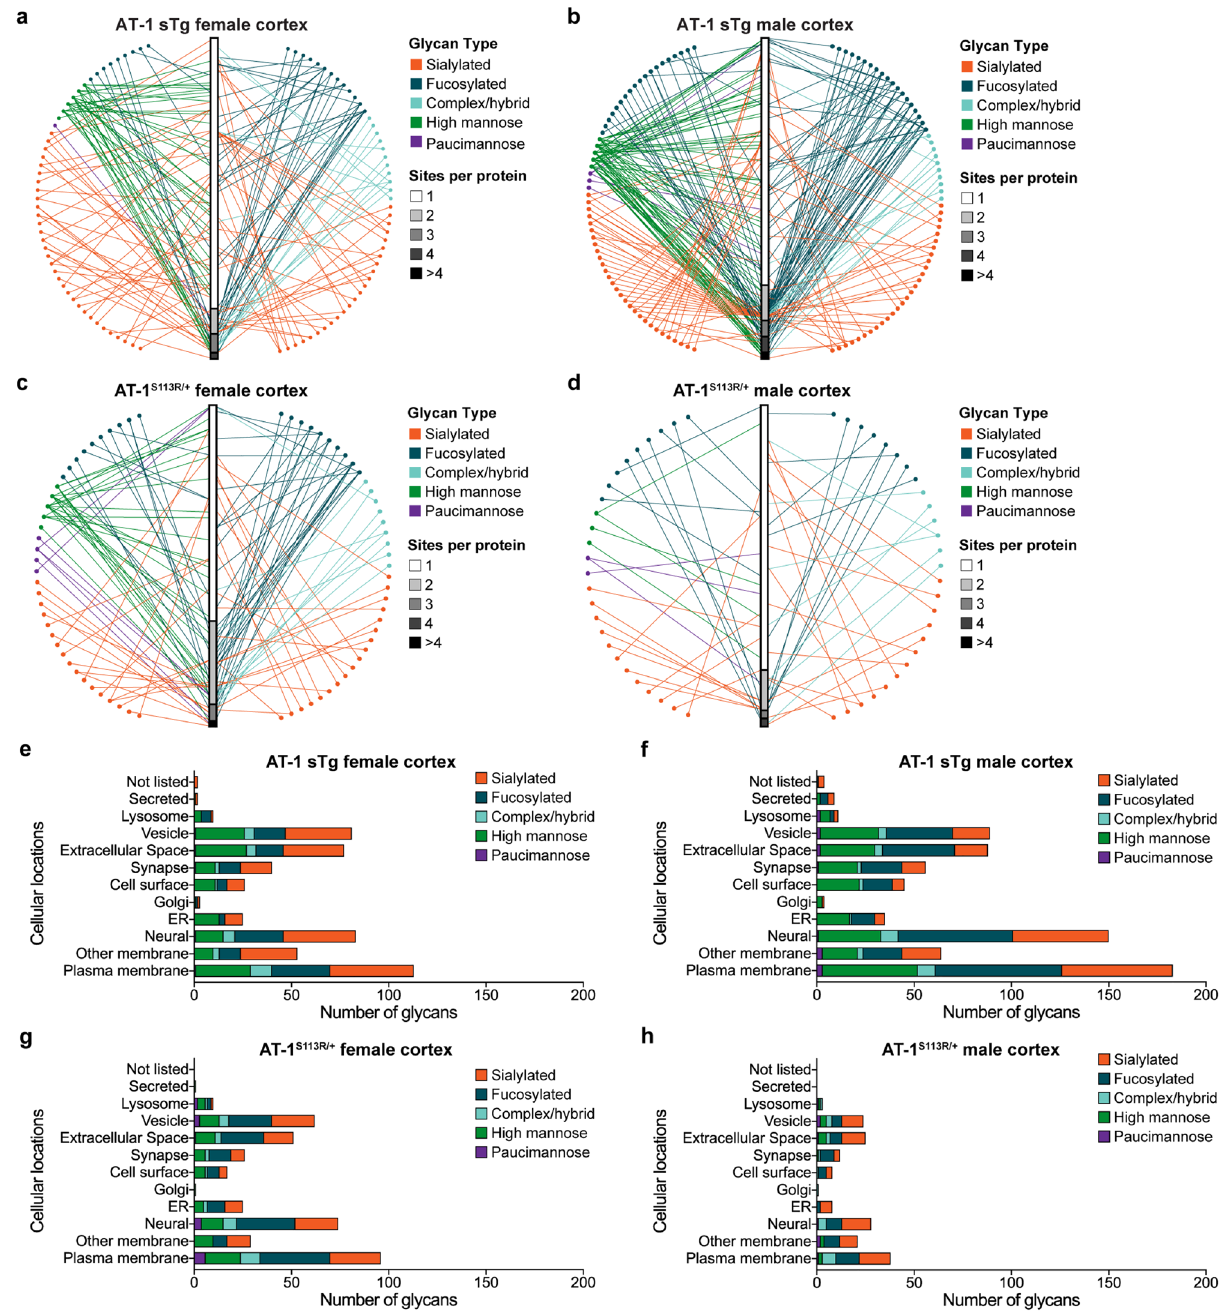
Figure 5. AT-1 sTg and AT-1 S113R/+ display a highly heterogeneous cortical secretome. ( a – d ) Network of significant glycan types plotted to glycoprotein for cortical ( a ) AT-1 sTg female, ( b ) AT-1 sTg male, ( c ) AT-1 S113R/+ female, and ( d ) AT-1 S113R/+ male. Circle represents glycan type, with each node representing a specific glycan tree. Glycans intersect with their protein, organized by the number of glycosites identified on that glycoprotein. ( e – h ) Glycosylation distribution according to subcellular localizations as defined by GO cellular component terms in cortical ( e ) AT-1 sTg female, ( f ) AT-1 sTg male, ( g ) AT-1 S113R/+ female, and ( h ) AT-1 S113R/+